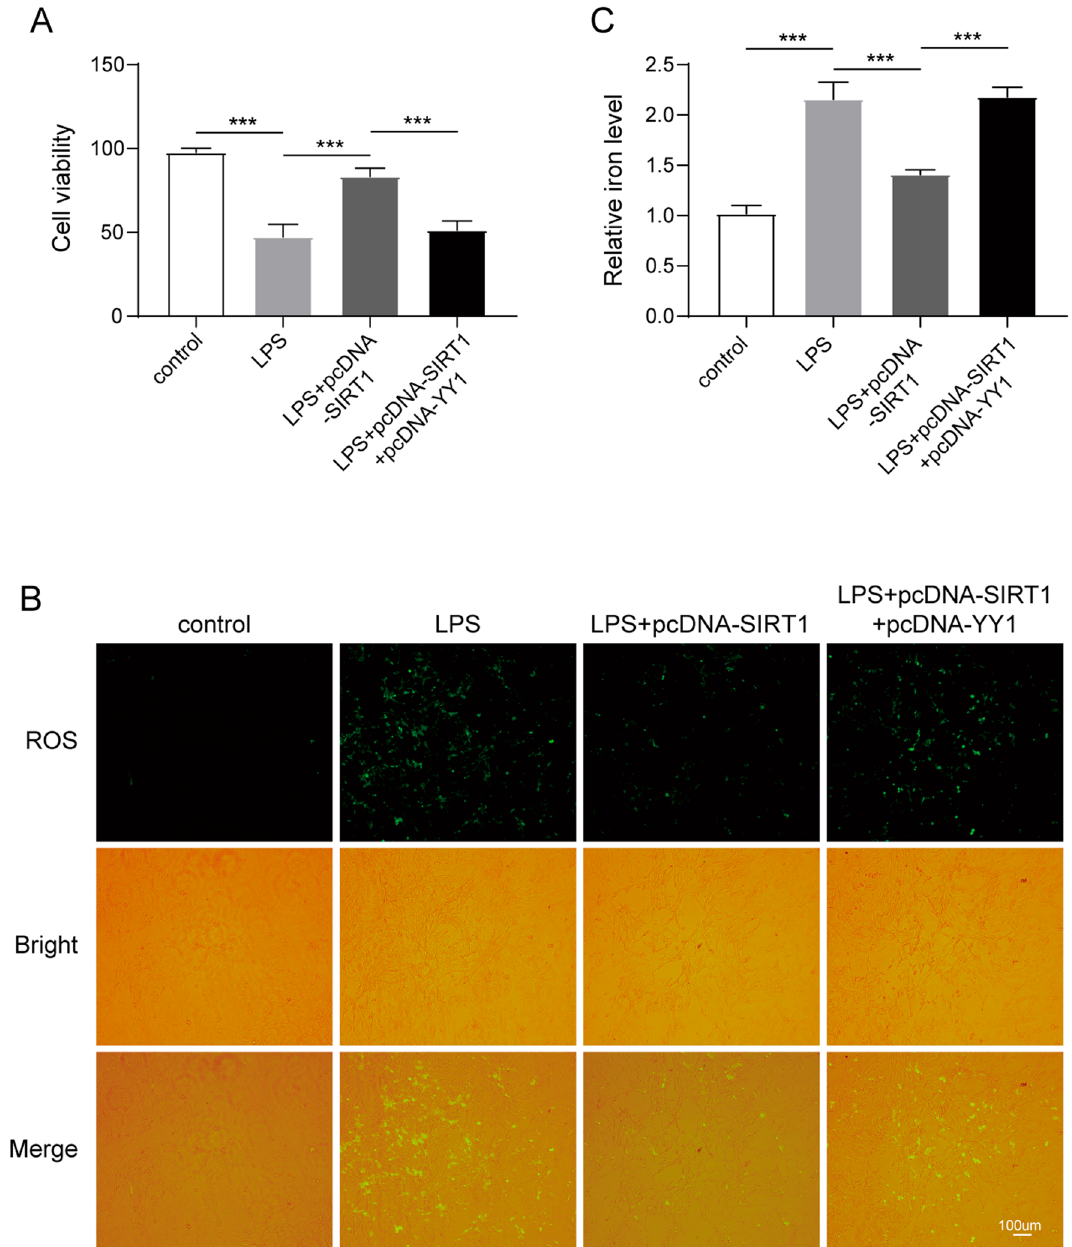
Fig. 5 YY1 promoted LPS-induced ferroptosis of synoviocytes through transcriptional inhibition of SIRT1. Synoviocytes were transfected